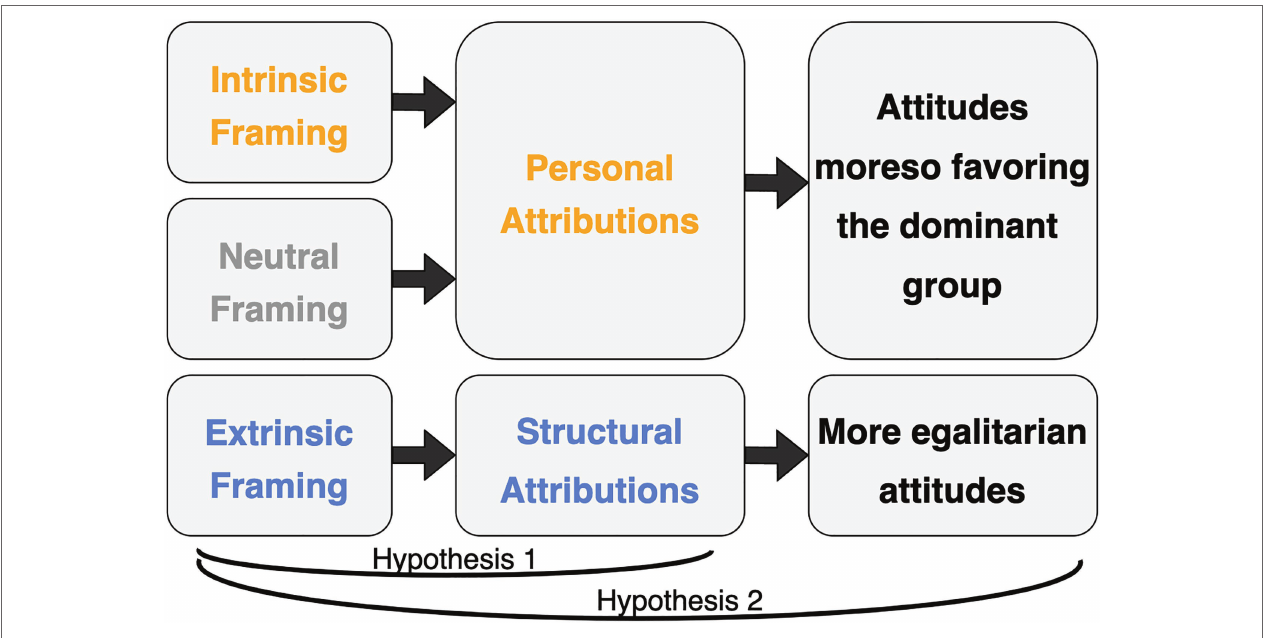
FIGURE 1 | Schematic of